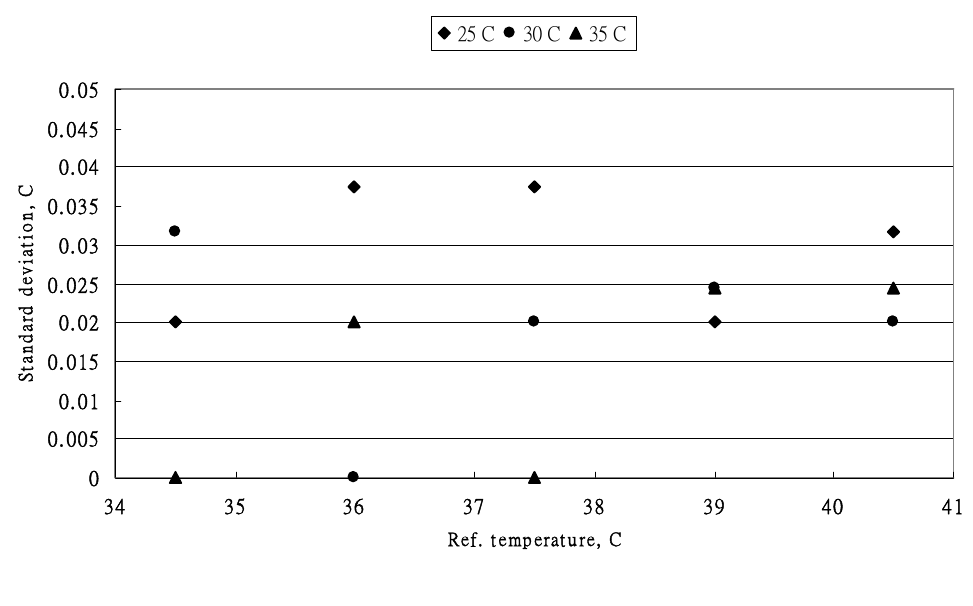
Figure 8. The standard deviation of five measurements of BRAUN IRT-3020 thermometer at different standard temperatures and three leaves of ambient